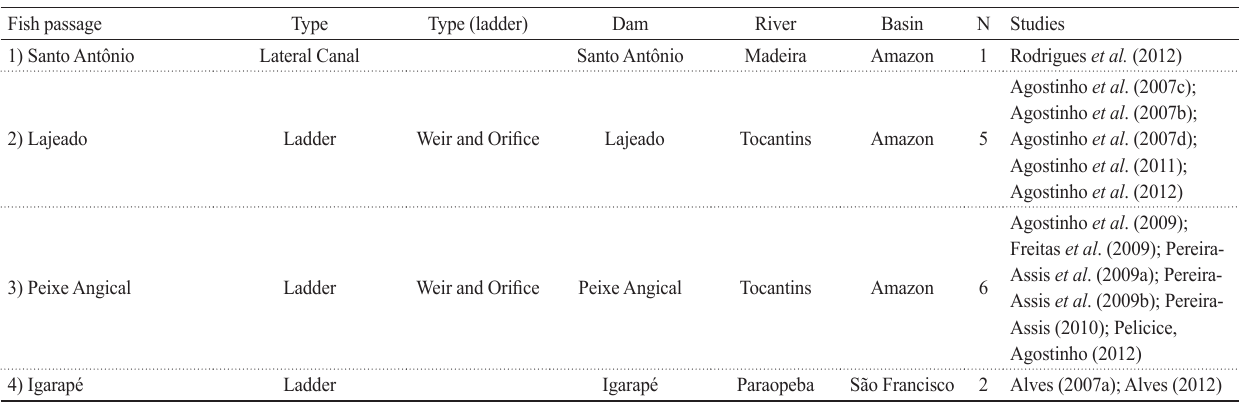
Tab. 1. Fish passage facilities in South America based on studies retrieved in our literature survey. N = number of studies. Review/synthesis and modelling papers are not listed in the table. Review/Synthesis papers: Agostinho et al . (2002); Agostinho et al . (2004); Baigún et al . (2007); Godinho, Kynard (2008); Lopes, Silva (2012); Pompeu et al . (2012); Pelicice et al . (2015). Modelling papers: Duarte et al . (2012); Santos et al . (2007); Santos, Martinez (2012); Santos et al .